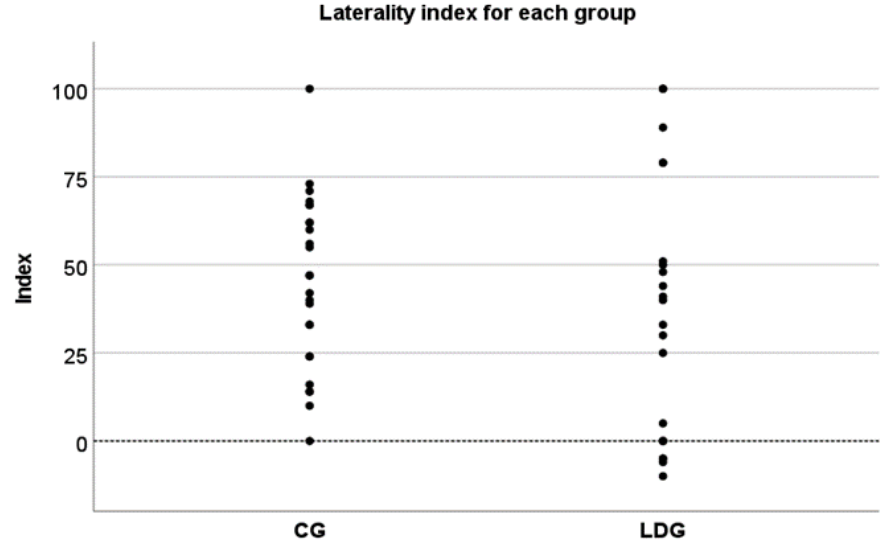
Figure 3. Degree of lateralization of each group with positive index representing right ear advan- tage. The groups showed similar magnitude of right ear advantage, with few participants of LDG demonstrating a left ear advantage (negative index).